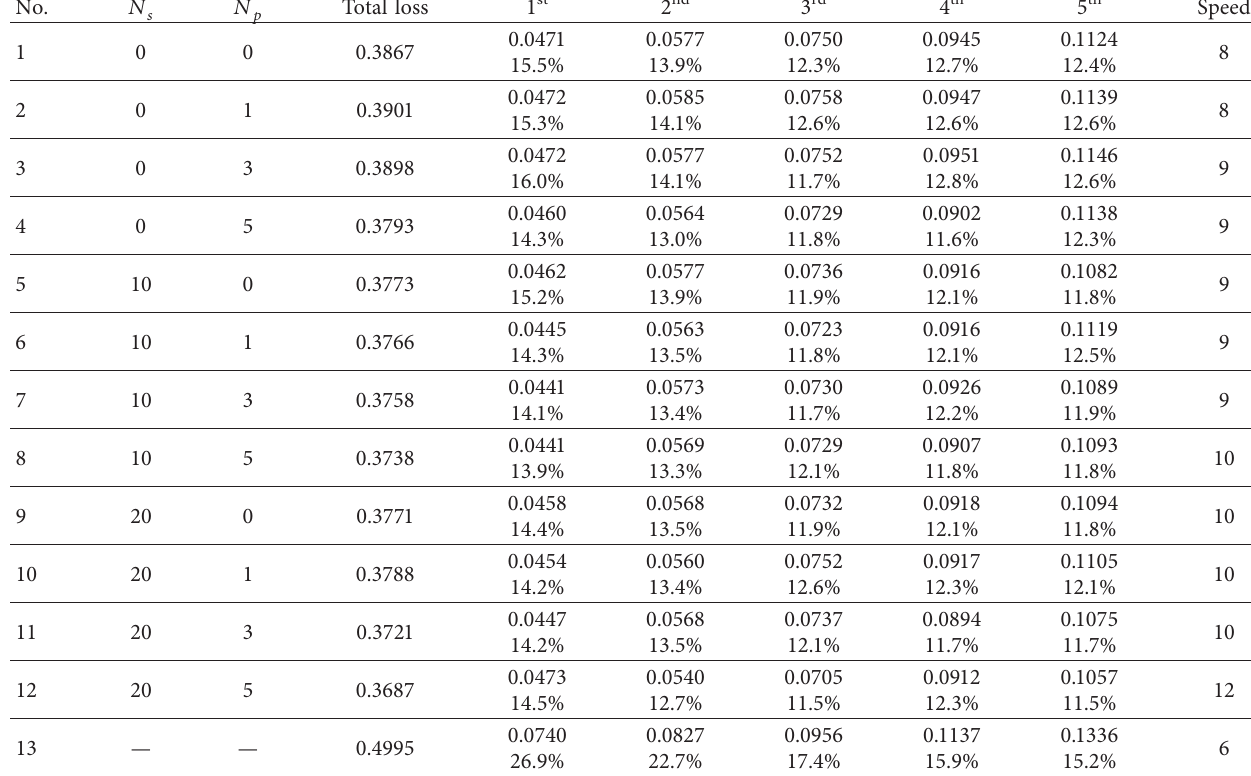
Table 3: Results of all models on the test